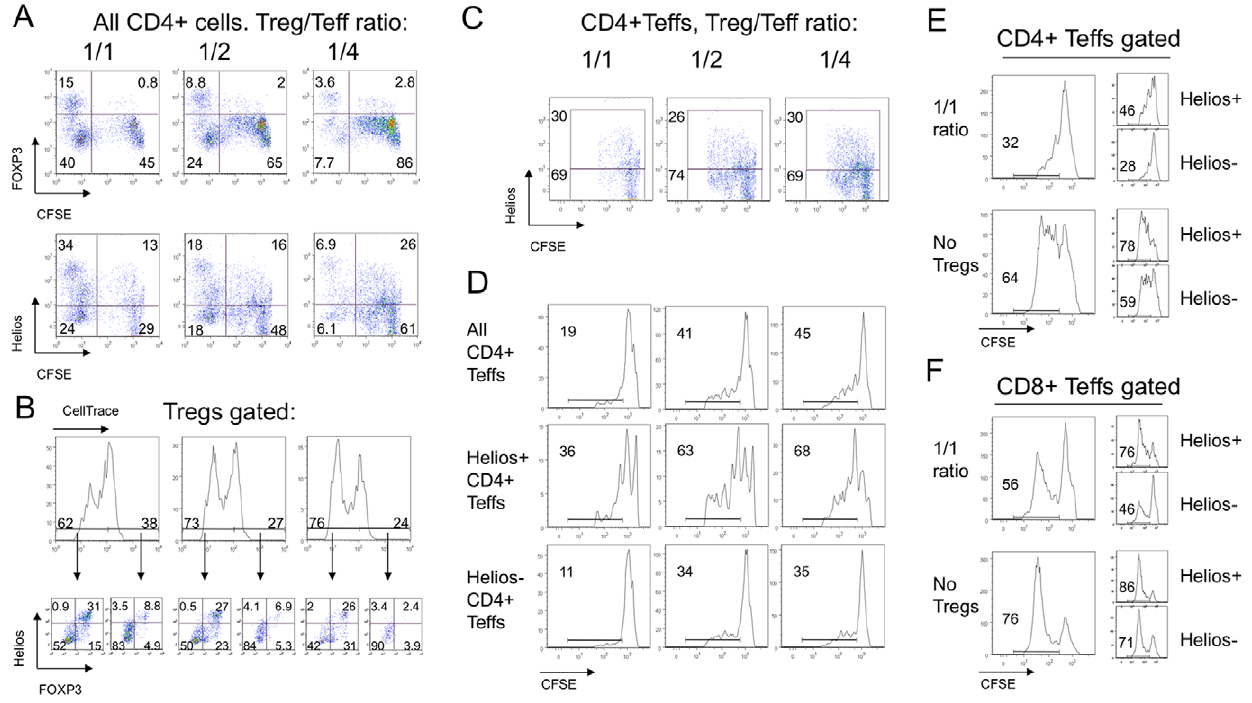
Figure 3. Upregulation of Helios expression by Teff cells in suppression assays. (A) Analysis of CD4 + gated murine Tregs and Teffs after 3 days of suppression assay showed that while Tregs gradually lose Foxp3 (top) and Helios (bottom) expression, a substantial proportion of Teff cells upregulate Helios (bottom), but not Foxp3 (top) expression; CFSE-negative gates show Tregs. (B) Treg division during suppression assays correlated with Helios and Foxp3 co-expression, while non-dividing Tregs lost both markers. Upper row: gating of dividing and non-dividing Tregs, with numbers showing % of Treg divisions at 1/1 (left), K (middle) and J (right) ratios; arrows point to Helios and Foxp3 co-expression in corresponding divided and non-divided Tregs subsets through the same 1/1 to J Treg/Teff ratios. (C) Tregs do not induce Helios expression in Teffs since CFSE + CD4 + Teffs have similar Helios expression despite differing numbers of Tregs (1/1, K and J ratios shown). (D) Analysis of Teffs gated into Helios + and Helios- subsets showed Helios + Teffs have a higher division rate and greater resistance to Treg suppression than Helios- mouse Teffs. Human Helios + CD4 + (E) and Helios + CD8 (F) Teffs showed higher divisions than Helios- cells regardless of Treg presence or absence, and Helios + responder cells were more resistant to suppression than Helios- responders. Data are representative of 3 experiments.